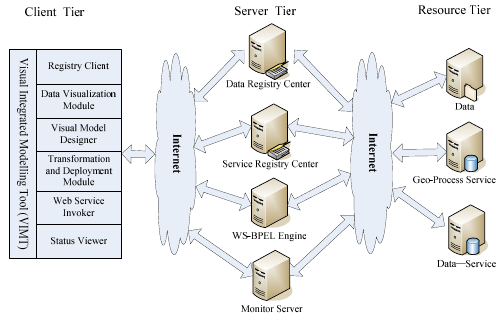
Figure 1. System architecture of GeoChaining